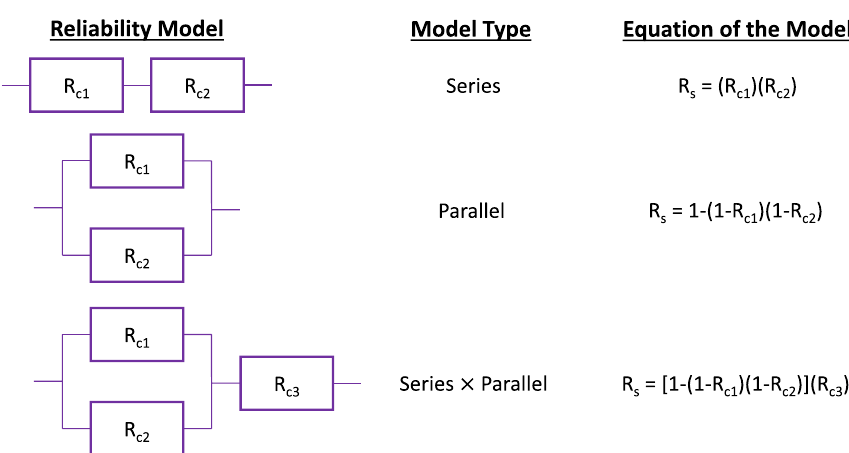
Fig. 12 The reliability model, model type, and equations of the models to develop the system reliability model (the component is denoted as R c